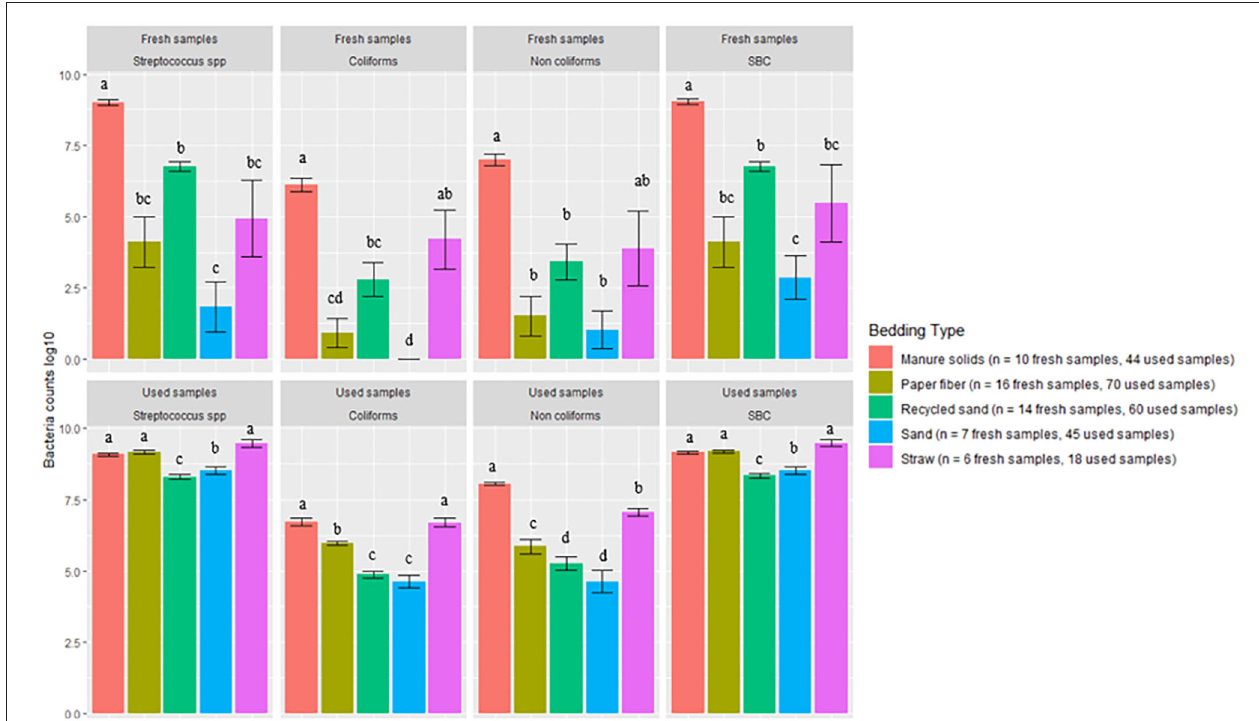
FIGURE 1 | Average bacterial counts (log10 CFU/g) for fresh and used bedding samples collected from July 2018 to July 2019 from five conveniently selected New York dairy herds using one of five bedding materials in lactating pens. One fresh bedding sample and three to five used bedding samples were collected monthly following an SOP at each visit (unless there was no bedding available due to lack of supply or equipment malfunction on the follow-up visit). Error bars represent SD. The same letters are not different at P ≤ 0.01 ( P -values adjusted for multiple contrasts). SBC (sum bacterial count) = Streptococcus spp, coliforms and non-coliforms